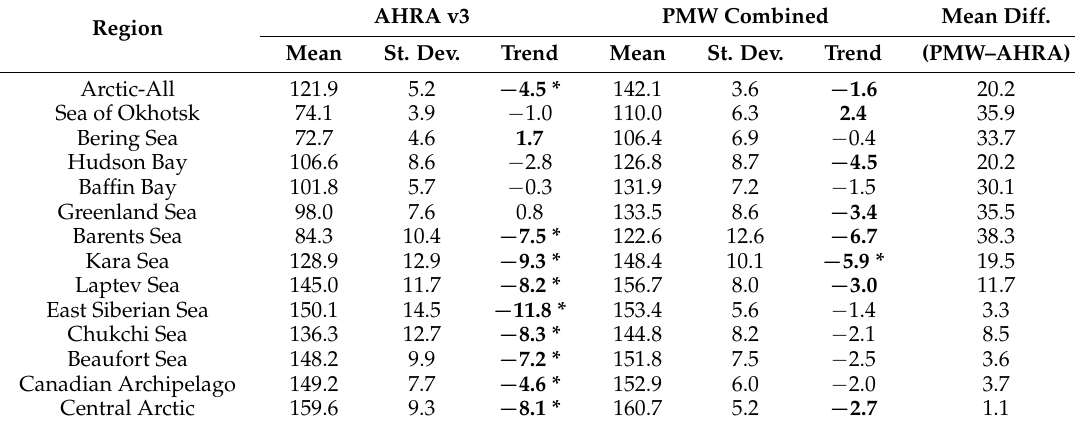
Table 2. Melt onset date regional a means, standard deviations, and the difference between means (days) and trends b (days · decade − 1 ) for 1979–2012. AHRA v3 PMW Combined Mean Diff. Region Mean St. Dev. Trend Mean St. Dev. Trend (PMW–AHRA) Arctic-All 121.9